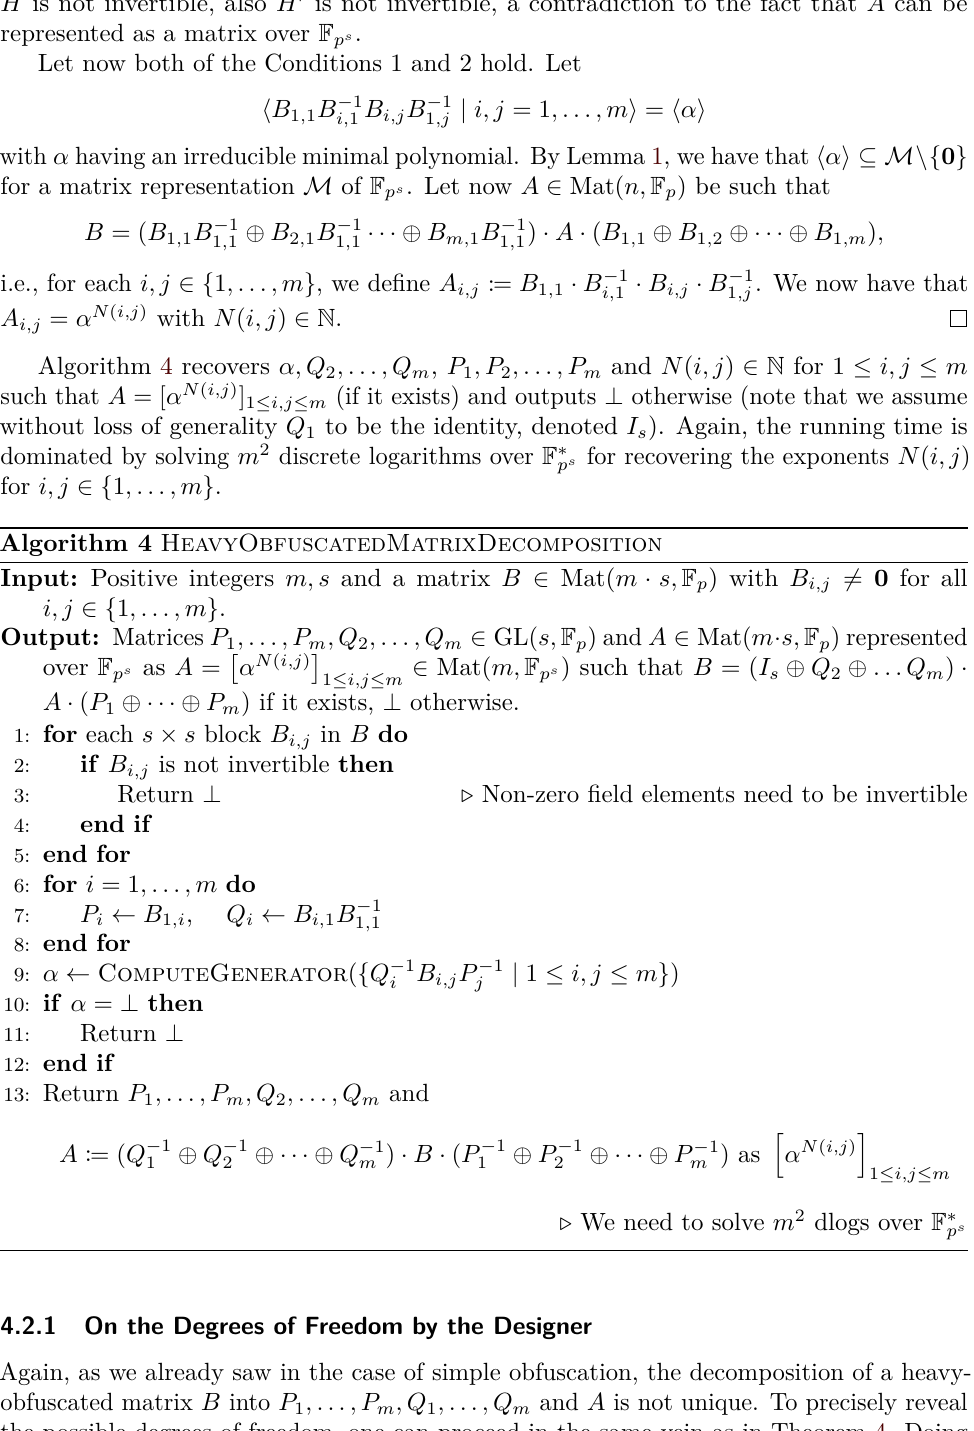
Algorithm 4 recovers α, Q 2 , . . . , Q m , P 1 , P 2 , . . . , P m and N ( i, j ) ∈ N for 1 ≤ i, j ≤ m